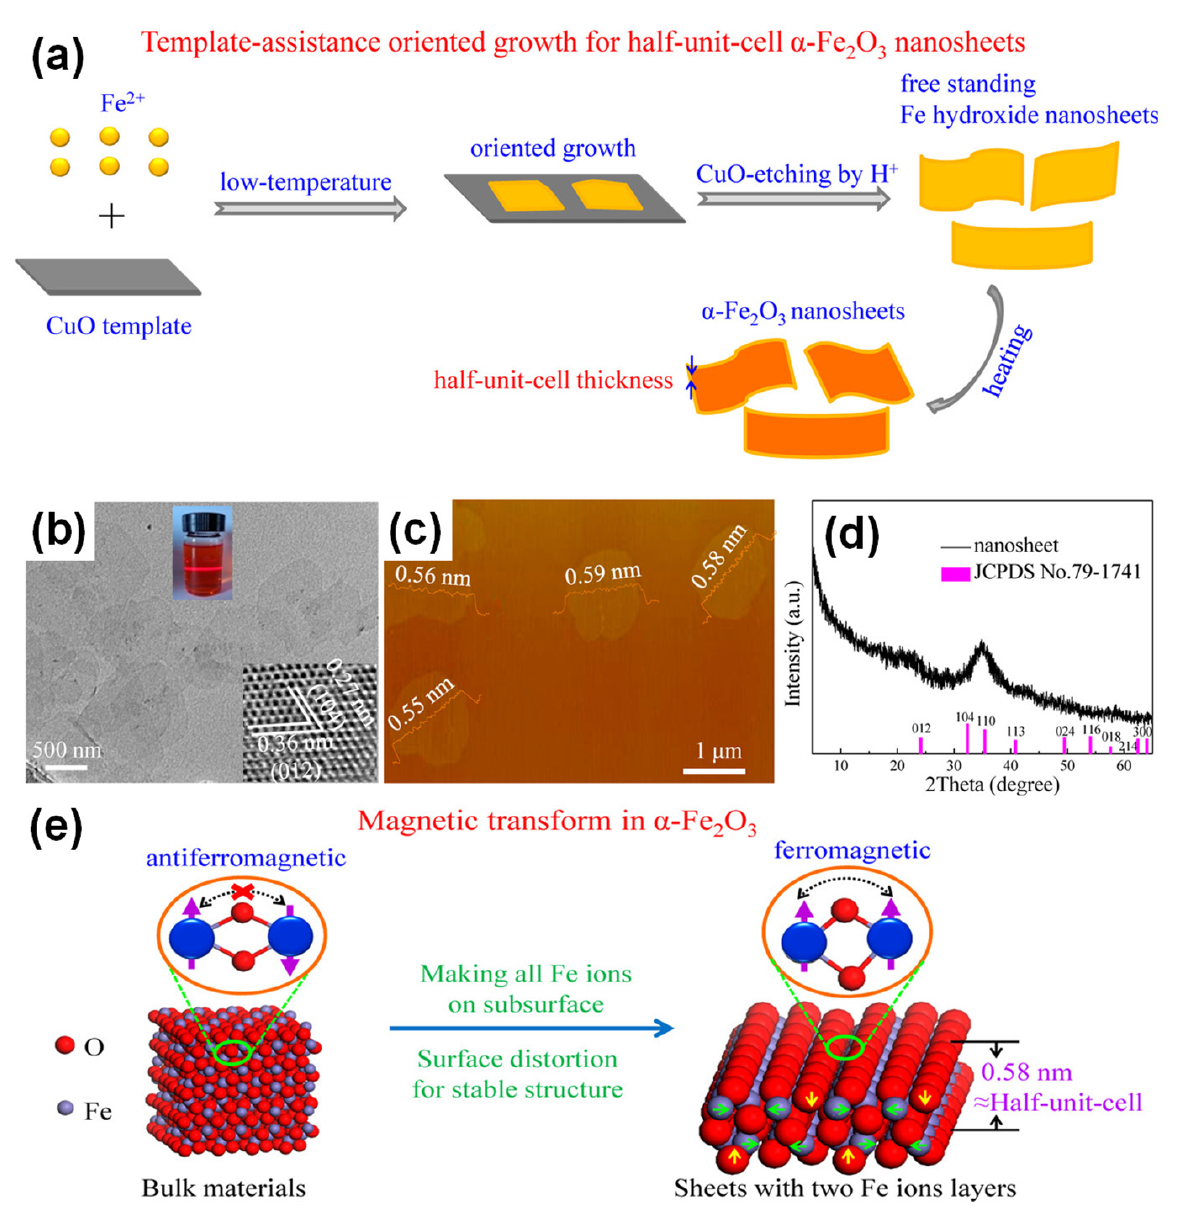
Figure 3. ( a ) Schematic of preparation process of the half-unit-cell α -Fe 2 O 3 nanosheets: ( b ) TEM image, ( c ) AFM image ( d ), XRD pattern of the α -Fe 2 O 3 nanosheets; ( e ) Schematic magnetic interaction turnover model for the α -Fe 2 O 3 nanosheets [33]. Copyright 2014, American Chemical Society.